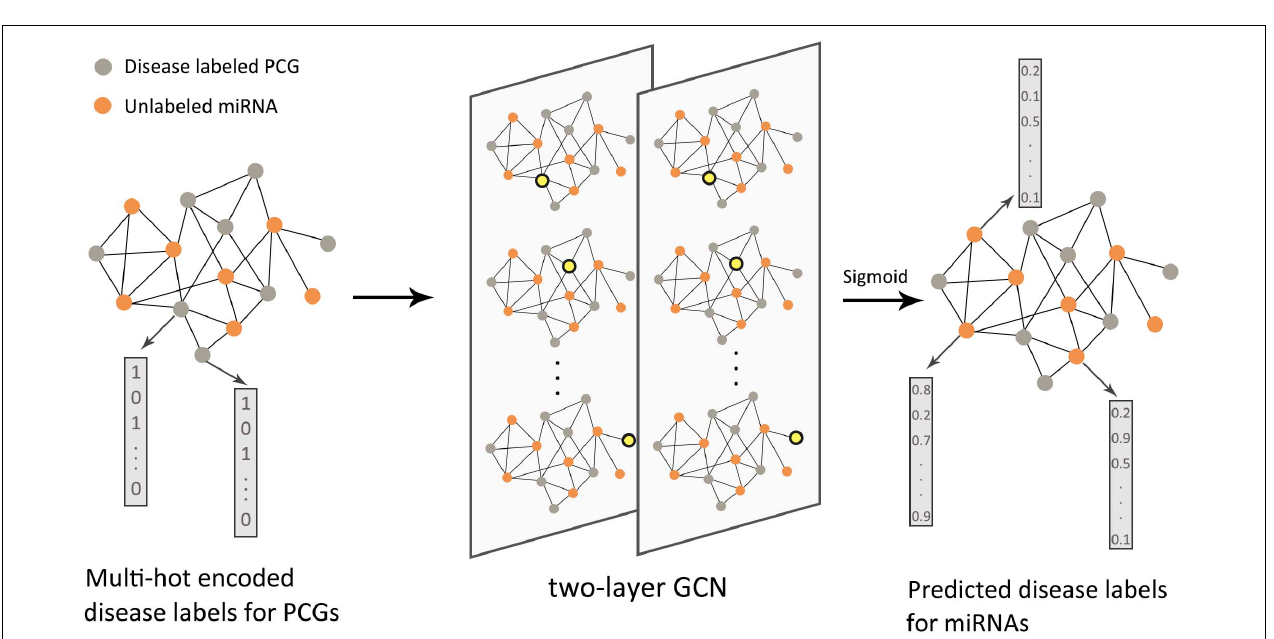
FIGURE 7 | Flow chart of DimiG in RNA–disease association. The protein-coding gene (PCG)–miRNA association network was used as the input of the two-layer graph neural network. The PCGs were labeled, and the miRNAs were unlabeled. The yellow nodes in the network represented the weighted sum of neighbor embeddings. The final output could infer the probability between diseases and unlabeled miRNAs.